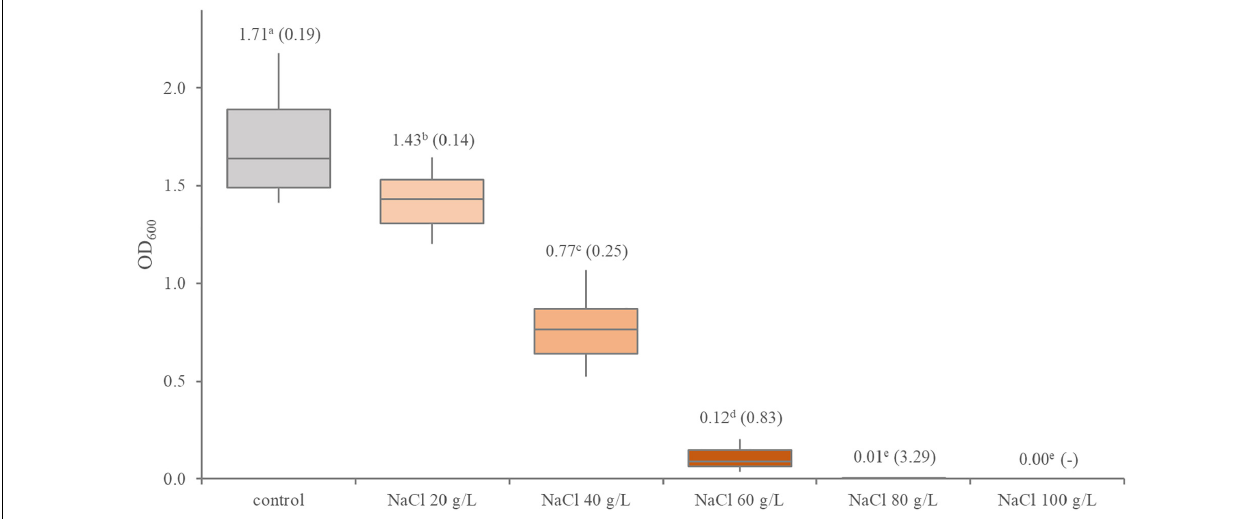
FIGURE 3 | Distribution of the growth performance of 12 Leuconostoc carnosum strains in presence of increasing concentrations of NaCl. Boxes indicate the 25th, 50th, and 75th percentiles; whiskers indicate the 10th and 90th percentiles. The labels report the mean and, in brackets, the coefficient of variation; different letter superscripts indicate means that significantly differ ( p < 0.05, ANOVA with Tukey’s post hoc ).